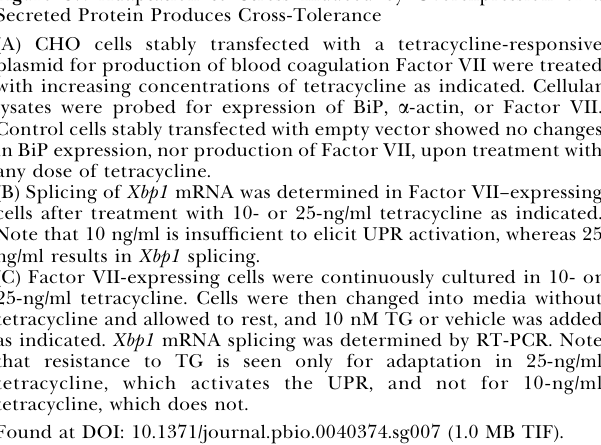
Figure S3. Adapted Cells Remain Pharmacologically Sensitive to TM and TG